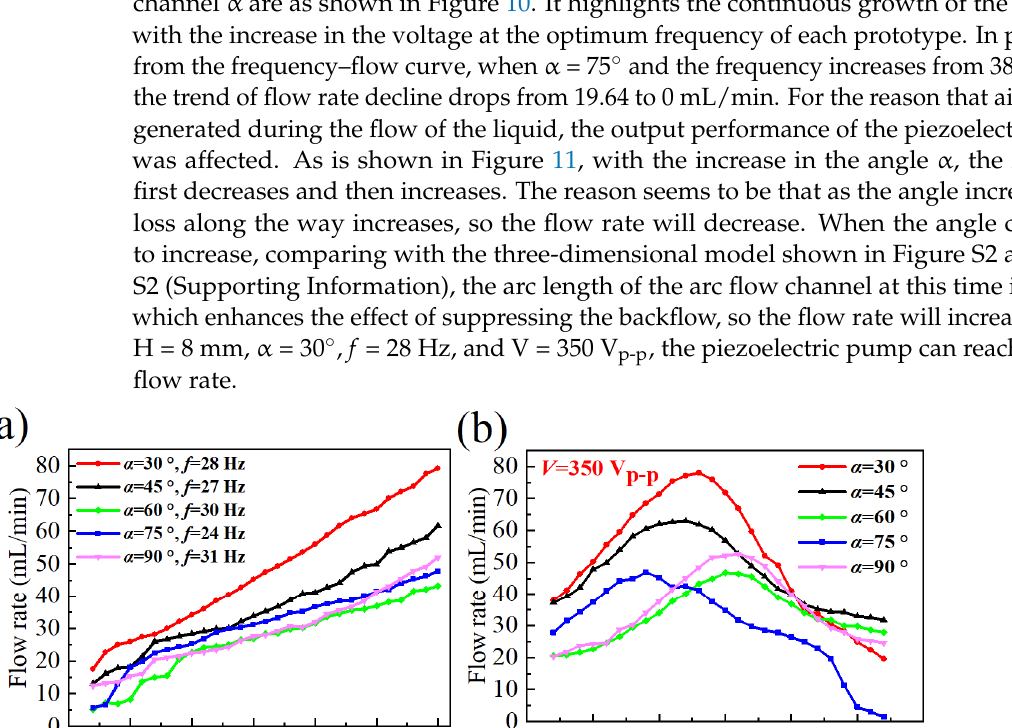
Figure 9. Corresponding maximum flow under different H.